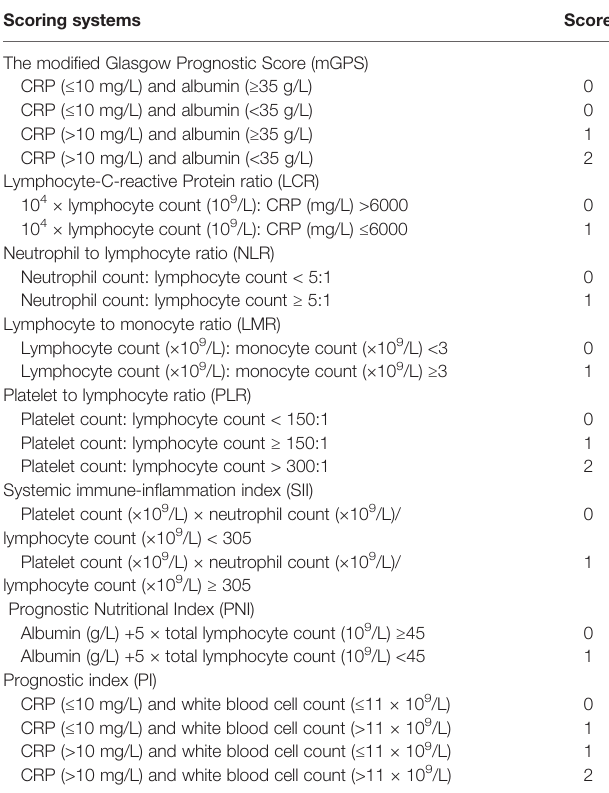
TABLE 2 | In fl ammation-based prognostic scoring